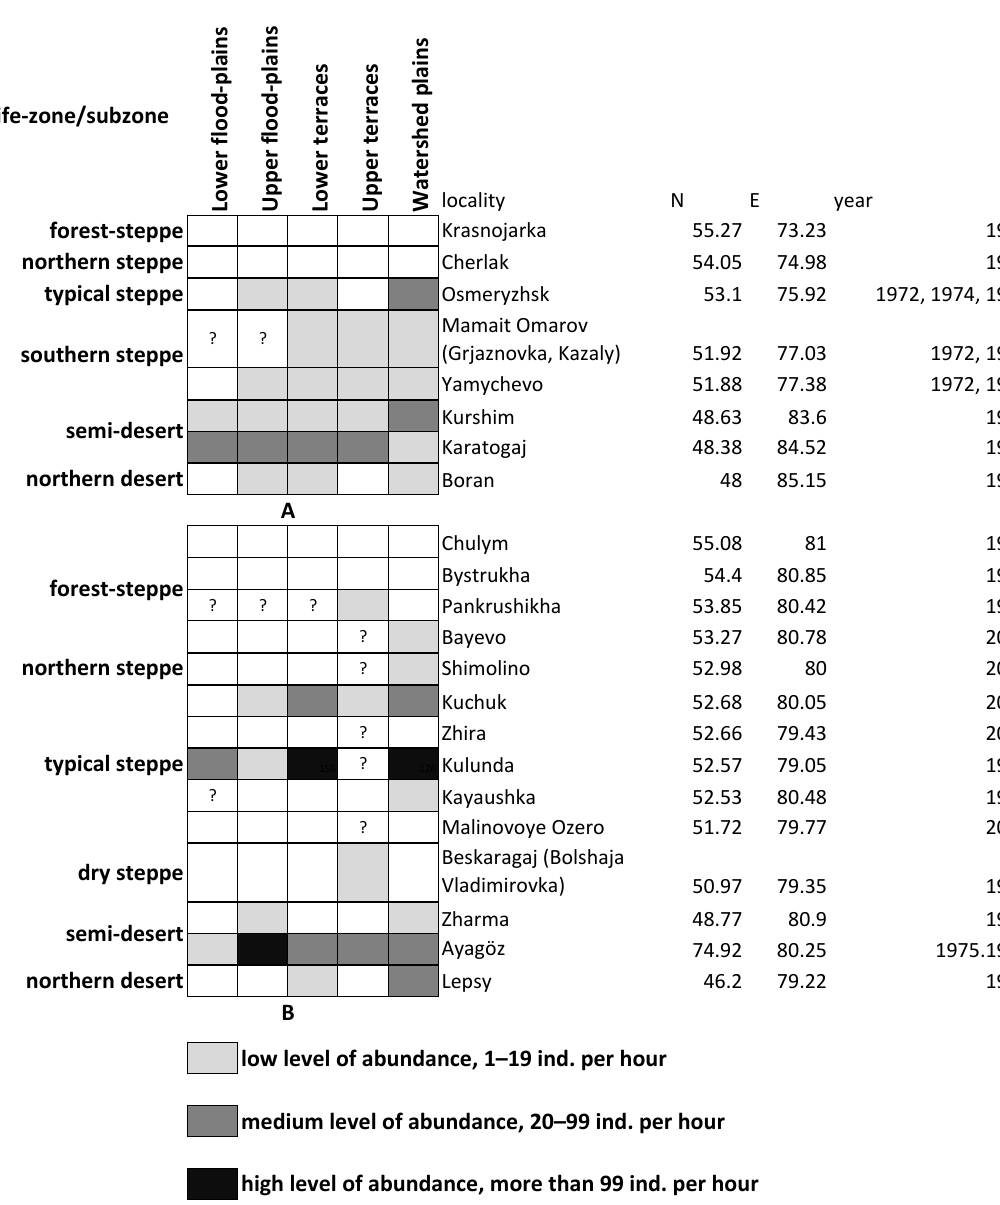
Figure 4. Population distribution of the Italian locust along two gradient (transzonal) transects crossing the south-eastern part of West Siberian Plain and the adjacent north-eastern and eastern parts of the Kazakh Uplands along the Irtysh River ( A ) and near the 80th meridian east ( B ). N—north;